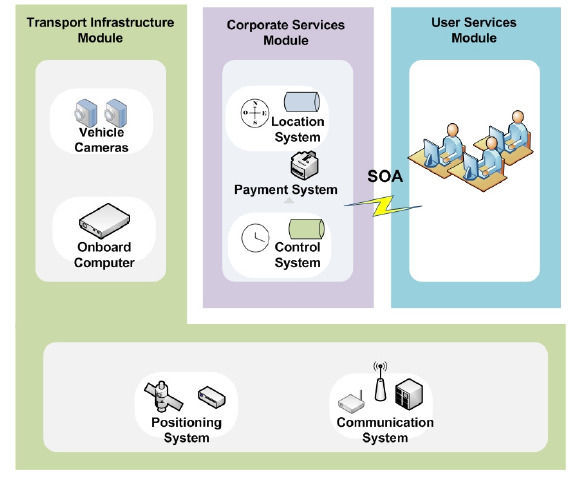
Figure 3. Overview of the proposed system architecture.